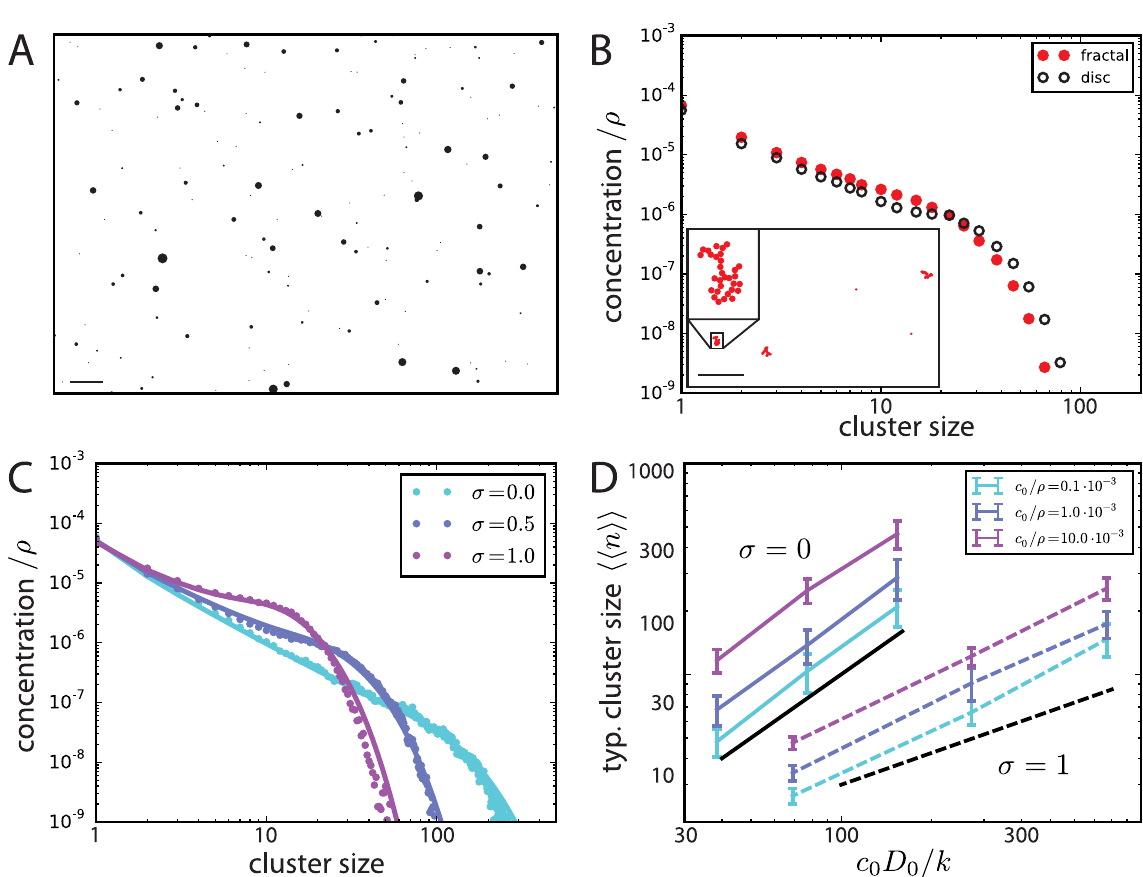
Fig 2. Simulations of scaffold domain formation. When not explicitlyvaried, simulationparameter values are k = 2.0 (cid:1) 10 − 5 D 0 ρ , c 0 = 0.9 (cid:1) 10 − 3 ρ , where ρ = 0.77 a − 2 and a is the diameterof basic particles, and the diffusionexponent(Eq (2)) is σ = 0.5. A: Snapshot of scaffold domaindynamics. Scale bar 100 a ; individualclusters are enlarged3-fold for better visualization. B: The characteristic distribution of observedcluster sizes does not dependon the detailsof internalcluster structure. The cluster size distribution is shown for the simulationin panel A (black circles) with perfect particle rearrangement, i.e. disc-like clusters, and for a simulation without any particle rearrangement but otherwiseidenticalparameters (red dots; simulationsnapshotand typical cluster shown in inset). Note that the density of fractal clusters is not constant and depends on cluster size; for comparison the density ρ = 0.77 a − 2 of disc-likeclusters is used here. Scale bar inset 50 a . C: Characteristic cluster size distributions of simulations with different diffusion exponents σ but otherwiseidenticalparameters (filled circles). The data for σ = 0.5 corresponds to the simulationshown in A. Superposed on the simulationresults are the theoretical curves obtainedfrom the rate equations(solid lines), see text for details. D: Scaling of the typical cluster size hh n ii with c 0 D 0 / k for different σ and c 0 . Solid black line: hh n ii / c 0 D 0 / k ; dashedblack line: hh n ii / ( c 0 D 0 / k ) 1/2